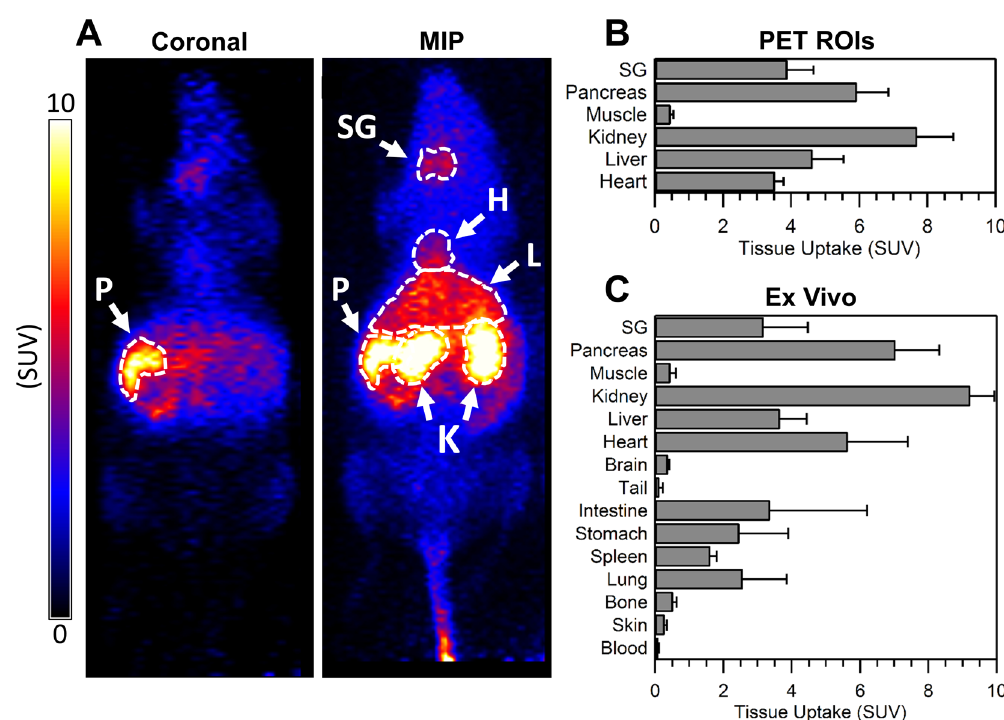
Figure 3. ( A ) Coronal slice and maximum intensity projection (MIP) static PET images of a representative ICR mouse injected intravenously with 51 Mn(II) (non-anaesthetized during injection). PET images were acquired one hour post-injection. Pancreas (P), salivary gland (SG), heart (H), liver (L) and kidneys (K) indicated by arrows. ( B ) 51 Mn tissue uptake quantification of hand-drawn PET ROIs in ICR mice (n = 3, mean ± SD) injected with a rapid intravenous bolus of 51 Mn(II). ( C) Ex vivo 51 Mn biodistribution in ICR mice (n = 3, mean ± SD) immediately following PET imaging, measured by gamma